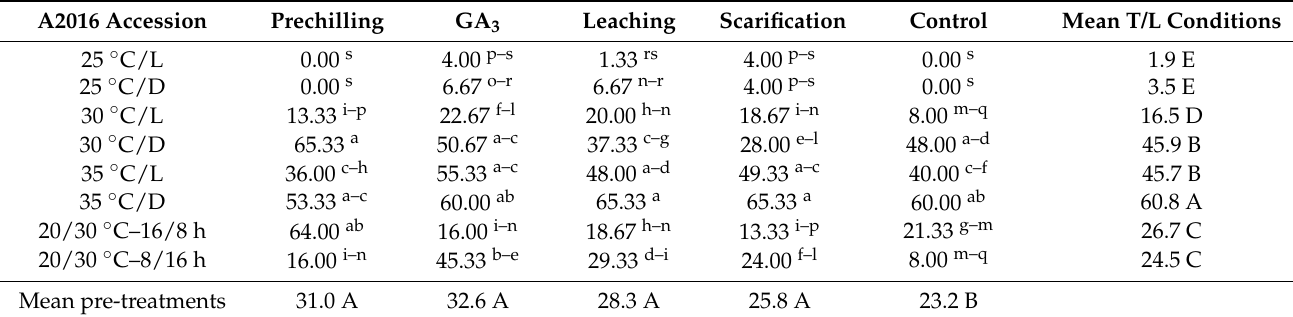
Table 5. Effect of the pre-germination treatments (A), temperature/light conditions (B), and their reciprocal interactions (A × B) on germination percentage of P. incarnata A2016